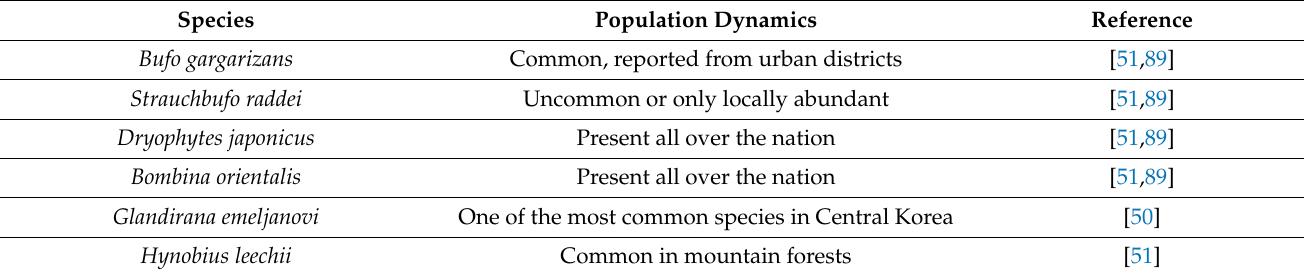
Table 4. Summary of population dynamics of amphibian populations in DPR Korea or closely related regions, extracted from the literature. W * indicates “workshop in Pyongyang in June 2019”. Here, [89] is cited as reported in